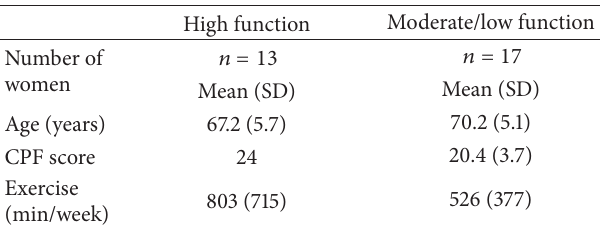
Table 1: Demographics and clinical features of participants by